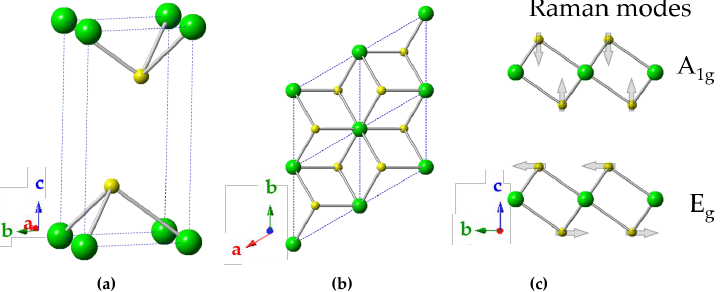
Figure 1. Representation of the crystal structure of ZrX 2 . Chalcogen atoms are represented in yellow and zirconium atoms in green. ( a ) Lateral view of a unit cell; ( b ) c -axis view of four unit cells; ( c ) extended view of the crystal structure where the layered structure can be appreciated. The out-of-plane Raman mode A 1g and the in-plane E g one are sketched. The gray arrows represent the relative movement of the chalcogen atoms while the zirconium one remains at